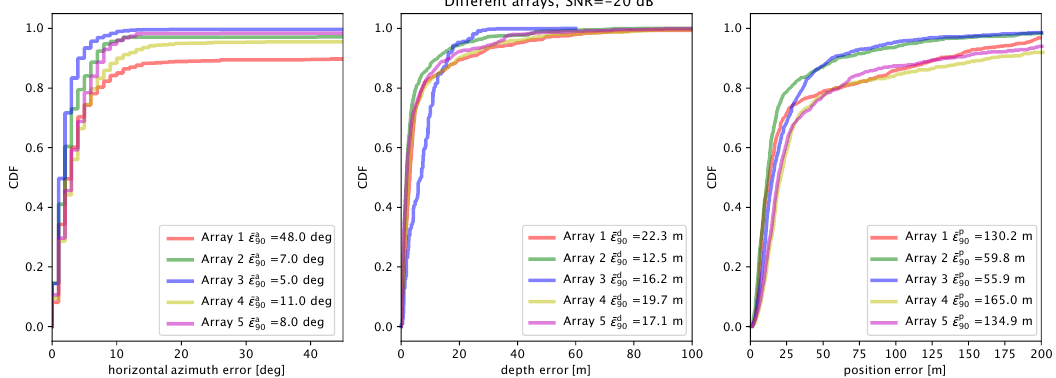
Figure 10. Localization error results for arrays 1 to 5, at an SNR of − 20 dB: azimuthal angle error ( left ); depth error ( center ); and total location error ( right ).